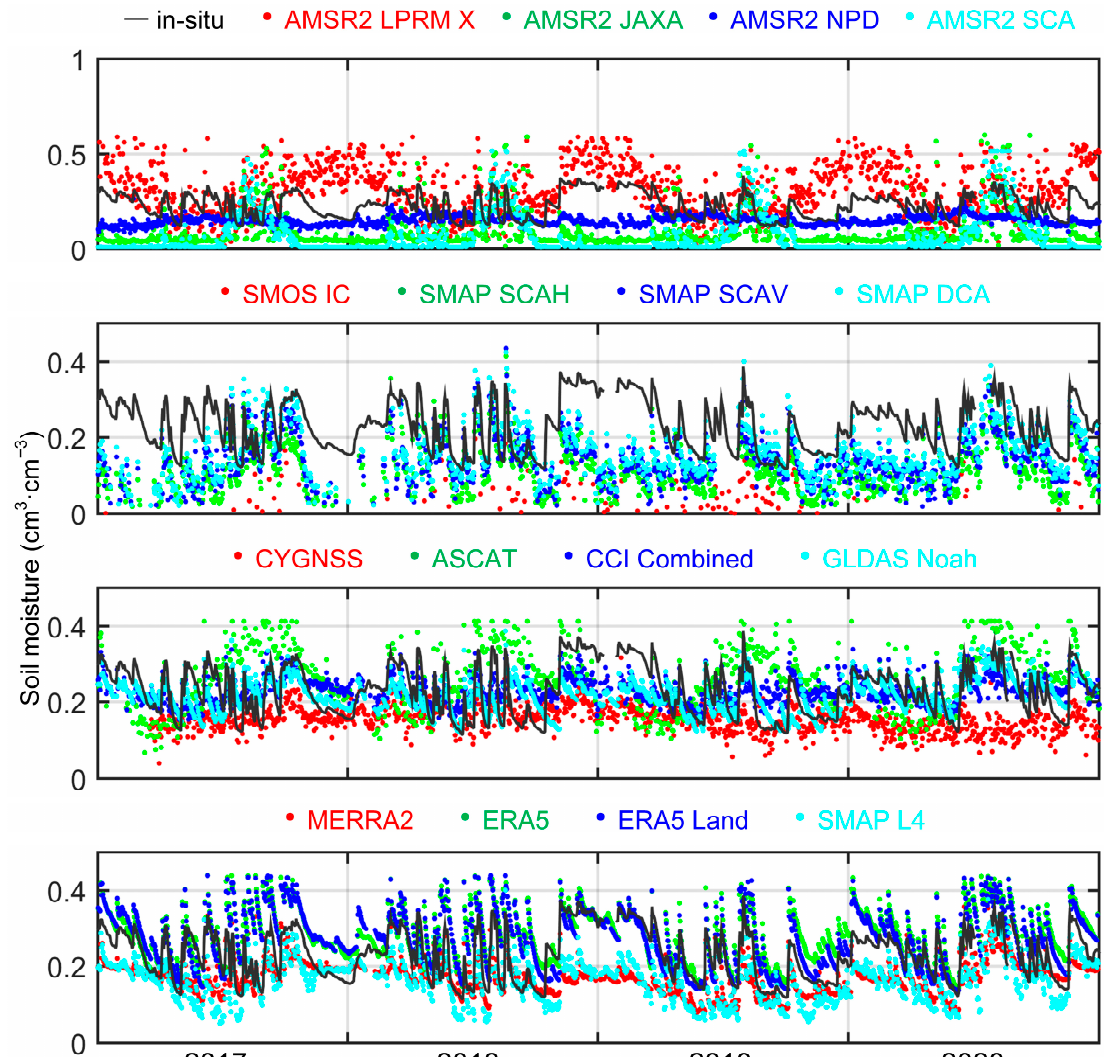
Figure 4. Daily soil moisture time series of a cropland station (station No.2 in Figure 1). Forced by meteorological datasets, all modeling-based products can well reproduce the temporal pattern of SM variabilities. It is interesting to observe that the 0–10 cm ERA5 and ERA5 Land products fit better with in situ observations for dry soils, and the 0–5 cm MERRA2 and SMAP L4 products fit better for wet soils (Figure 4). The depth of the top soil layer and the quality of the forcing datasets might account for the differences. A detailed comparison of in situ observations is shown in Figure 5. Considering data availability and overall accuracy, only six major products are presented here. Regression slope values can manifest the dynamic range of SM values. ERA5 has the largest SM dynamic range, followed by SMAP L4, MERRA2, ESA CCI Combined, GLDAS Noah and